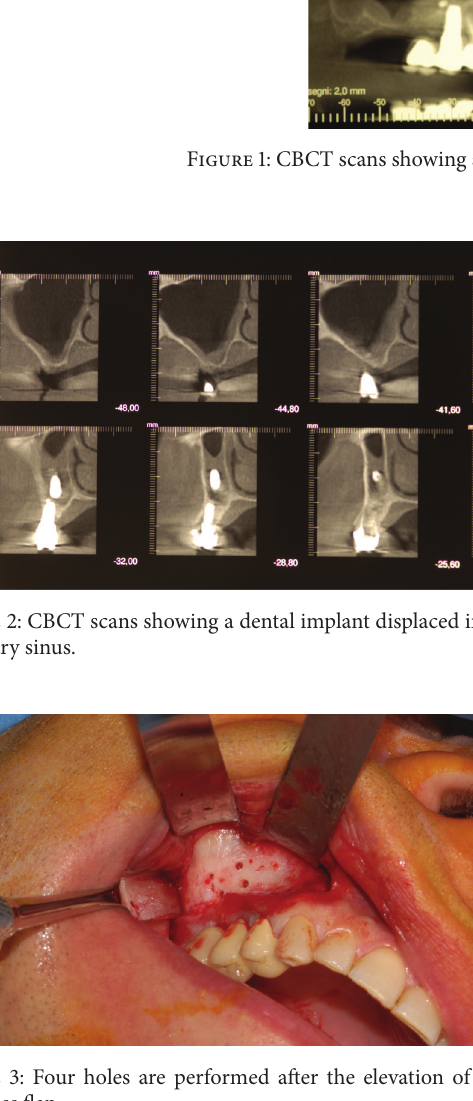
Figure 3: Four holes are performed after the elevation of a full- thickness flap.